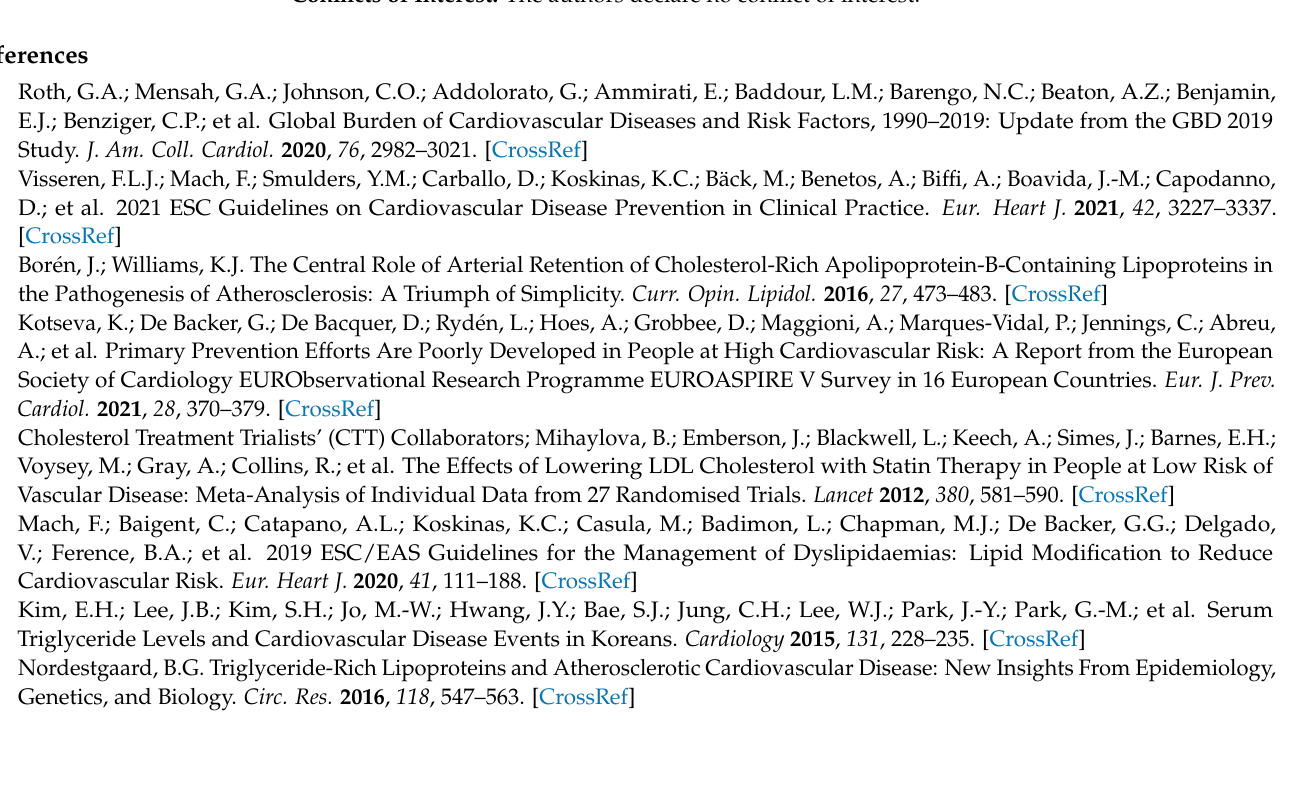
Figure S4: Determinants of sdLDL-C ≥ 1.0 mmol/L ( ≥ 40 mg/dL) based on the results of the univari- ate analysis.; Figure S5: Determinants of Lp(a) ≥ 50 mg/dL based on the results of the univariate analysis.; Figure S6: Determinants of LDL-C < 2.6 mmol/L (<100 mg/dL) based on the results of the univariate analysis.; Figure S7: Determinants of TG < 1.7 mmol/L (<150 mg/dL) based on the results of the univariate analysis.; Figure S8: Determinants of Lp(a) < 30 mg/dL based on the results of the univariate